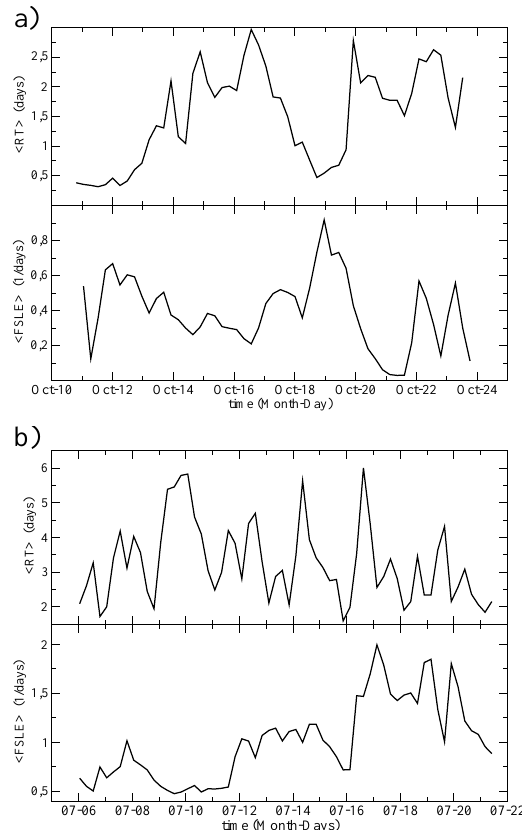
Fig. 10. (a) Time series throughout October of the spatial average of residence times (top) and spatial average of FSLE (bottom) for the surface layer of the Bay of Palma. (b) Same as (a) but for